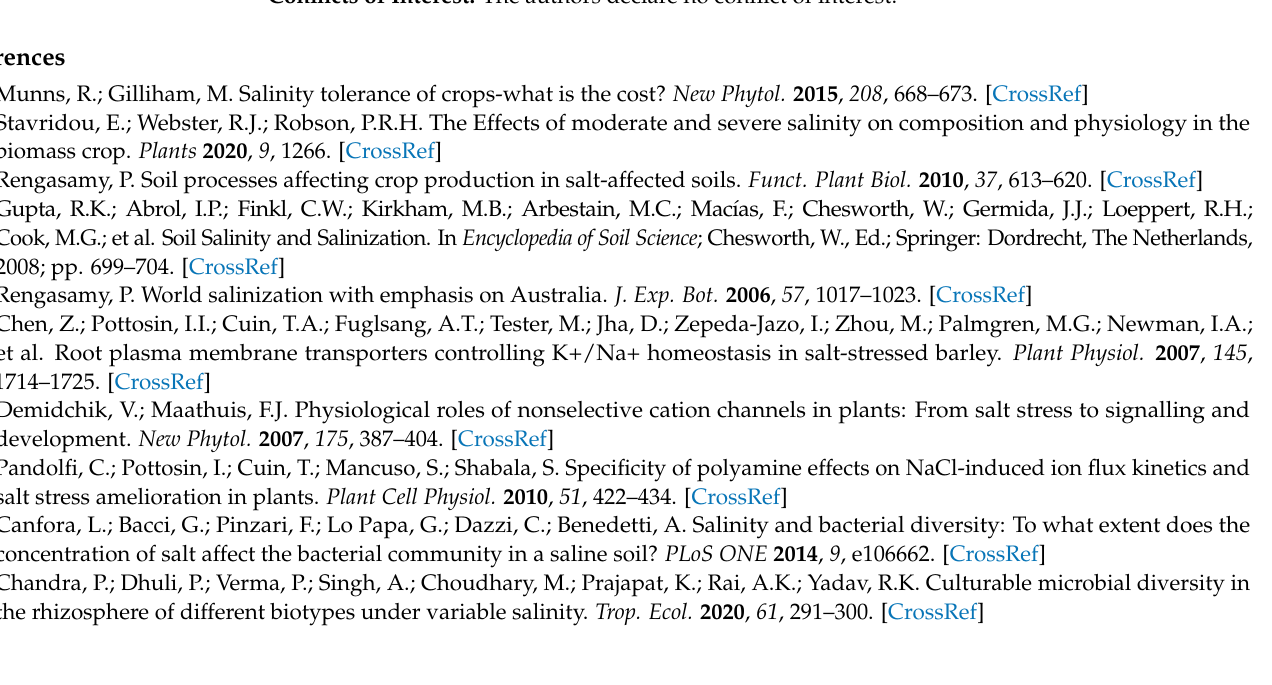
Figure S2: Assessment of tolerance to saline irrigation of melon cv. Ofir and tomato cv. M82 plants. Figure S3: Growth of tomato (cv. M82) seedlings in response to inoculation with Azospirillum brasilense Sp7 (Ab), Paenibacillus dendritiformis T (Pb), and their combination (Ab+Pb). Figure S4: Growth of tomato (cv. M82) plants in response to inoculation with Azospirillum brasilense Sp7 (Ab), Paenibacillus dendritiformis T (Pb), and their combination